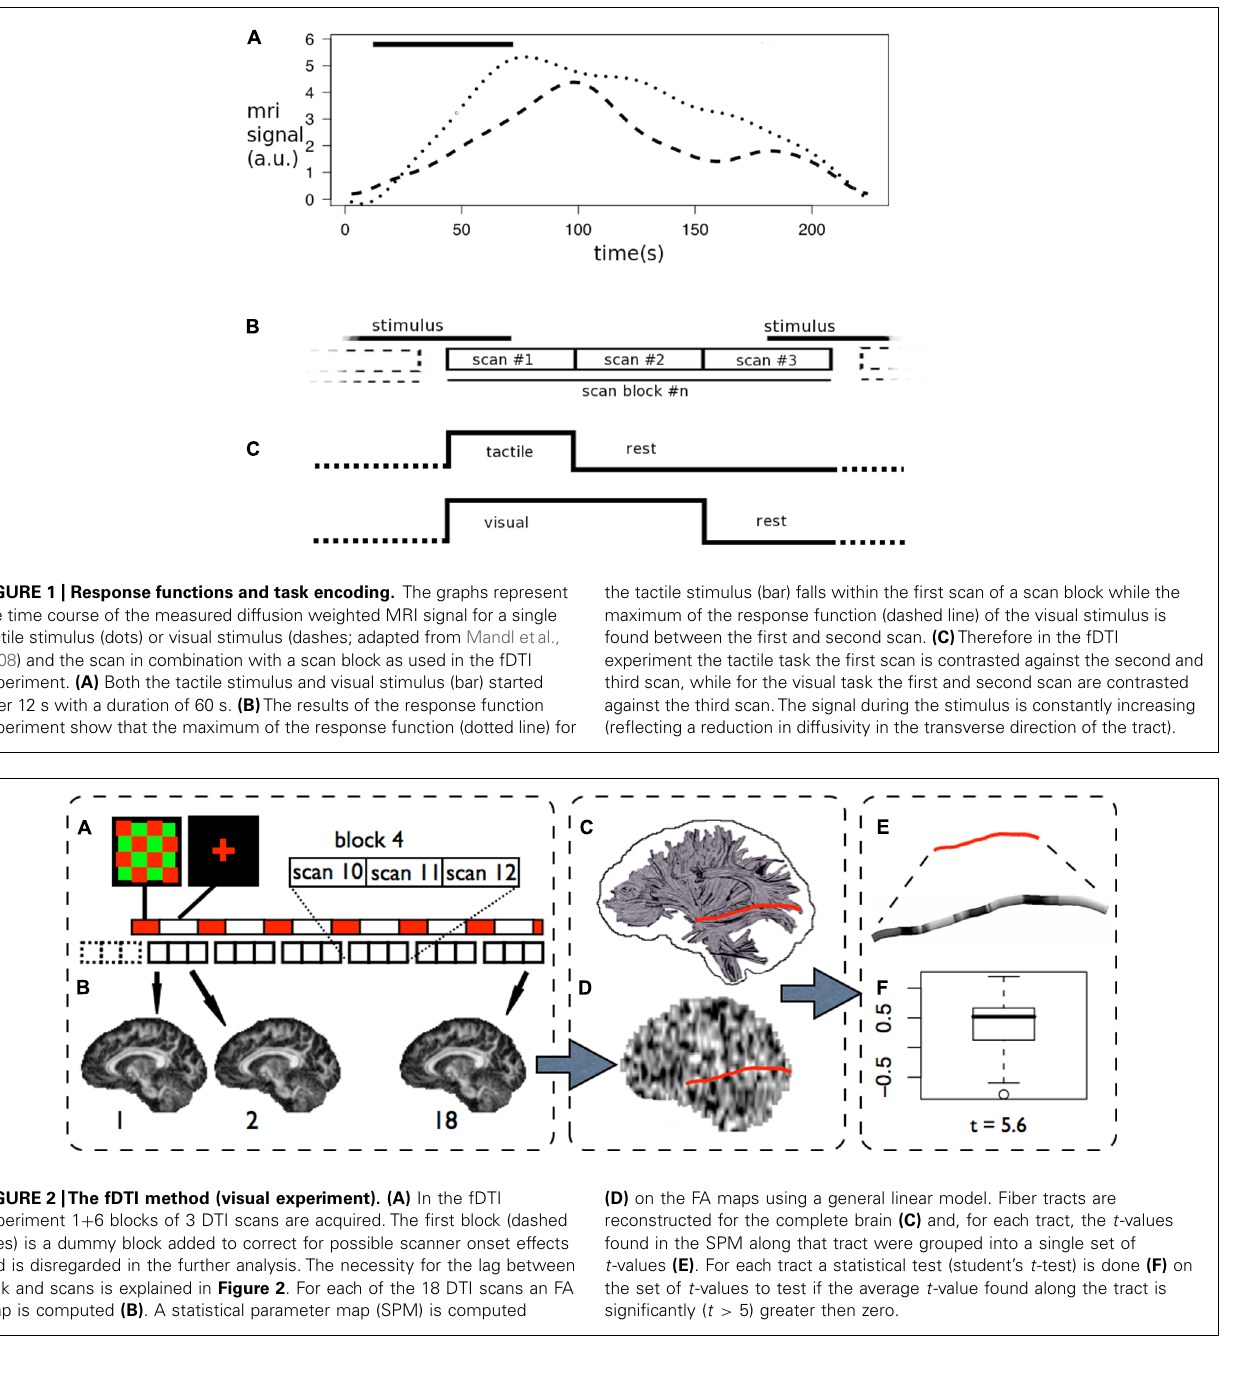
FIGURE 2 |The fDTI method (visual experiment). (A) In the fDTI experiment 1 + 6 blocks of 3 DTI scans are acquired. The first block (dashed lines) is a dummy block added to correct for possible scanner onset effects and is disregarded in the further analysis. The necessity for the lag between task and scans is explained in Figure 2 . For each of the 18 DTI scans an FA map is computed (B) . A statistical parameter map (SPM) is computed